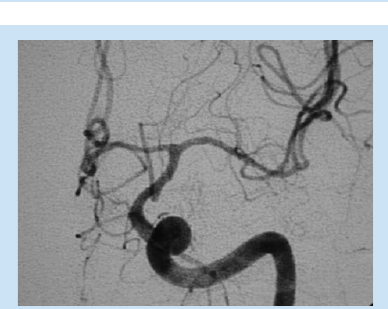
Fig. 1b. Mirror oblique projection, left internal carotid artery showing diffuse vasospasm on this side as well.